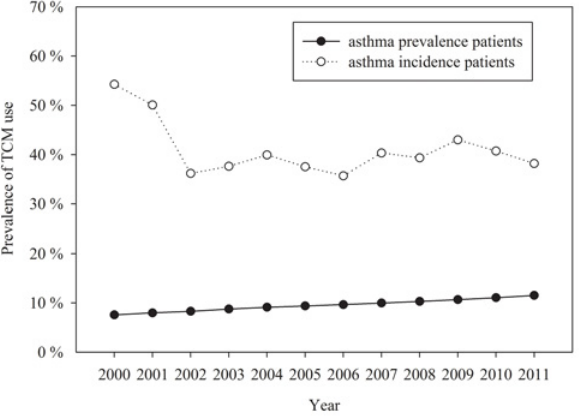
Fig 1. Time trends in the prevalence of TCM use among asthma prevalent and incident patients.